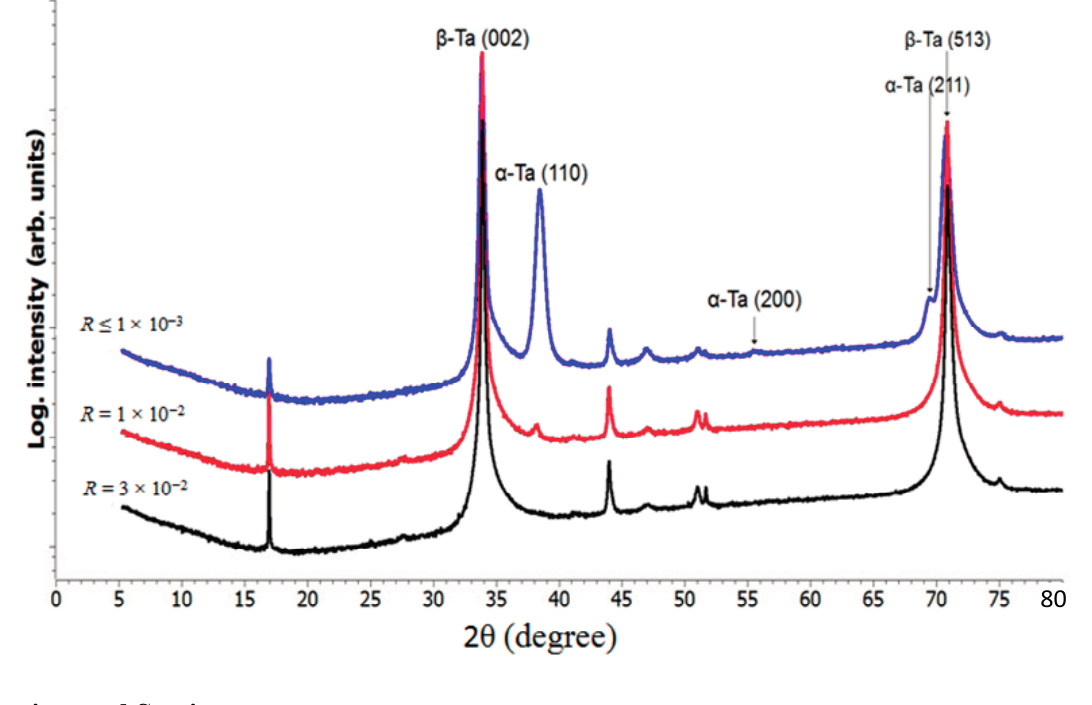
/Ar current ratio R 32 40